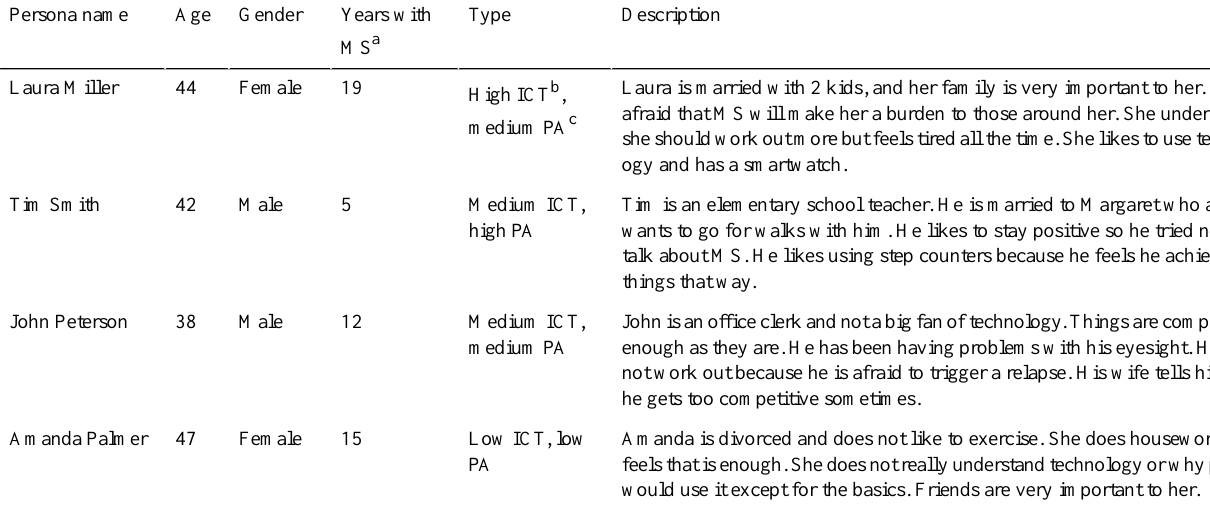
Table 3. Multiple sclerosis personas’synopsis.